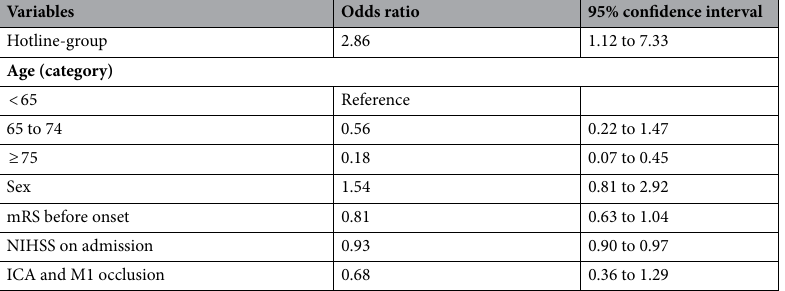
Characteristics of the non-hotline group (N = 34)